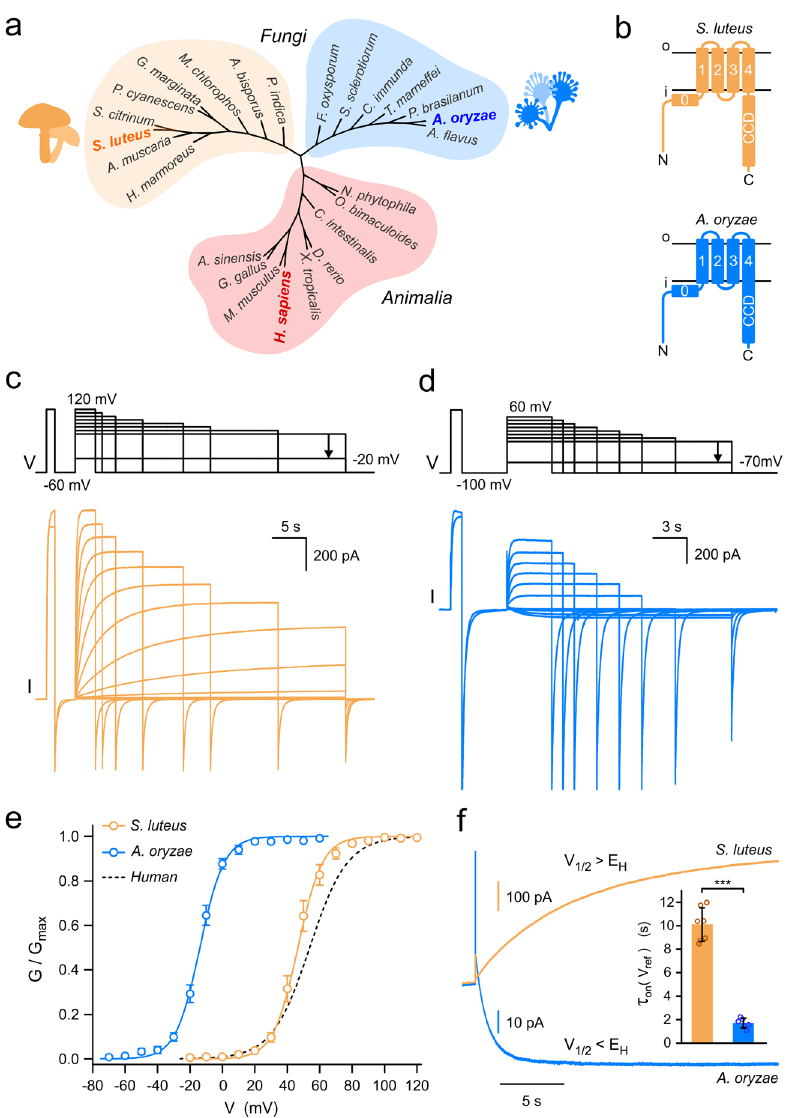
Fig. 1 Fungal Hvs from species S. luteus and A. oryzae show distinct biophysical properties. a Unrooted cladogram places Hv channels of fungi into two large groups distinct from animal orthologs. b Predicted topology of Hvs from S. luteus and A. oryzae showing connections between C-terminal coiled-coil domains (CCD) and S4 transmembrane segment of different lengths. c , d Representative proton currents from fungal Hvs shown in ( b ) expressed in Xenopus oocytes and measured from inside-out patches (pH = pH = 6.0). For clarity, only the fi rst and last traces elicited by the depolarization pre-step i o are shown. e Conductance versus voltage relationships ( G – V s) of SlHv1 and AoHv1 calculated from current traces like those shown in ( c , d ). Curves are Boltzmann fi ts. For SlHv1, V 1/2 = 46.5 ± 2.3 mV, slope = 7.6 ± 0.5 mV; for AoHv1, V 1/2 = − 13.9 ± 1.1 mV, slope = 7.4 ± 0.9 mV ( n = 5). Error bars are SEM. G – V for hHv1 is shown as dashed line for reference ( V = 53 ± 3 mV, slope = 11.6 ± 0.6 mV, from ref. 28 ). f Representative activation currents of SlHv1 and 1/2 AoHv1, each measured at a reference voltage ( V ref ) closest to their individual V 1/2 ( V ref = 50 mV for SlHv1 and − 10 mV for AoHv1). At V ref , G / G max is 0.61 and 0.63 for SlHv1 and AoHv1, respectively. E H indicates Nernst potential for protons, which in this case is 0 mV. Time constants of activation currents ( τ on ( V ref )) are shown in inset as mean values ± SEM ( n = 7 for SlHv1; n = 6 for AoHv1). Welch ’ s t -test was used for statistical analysis, *** p < is observed with the large majority of Hvs from the animal with SlHv1 activating slowly, and at positive membrane poten- kingdom 11 . AoHv1, on the other hand, opens when the tials, and AoHv1 activating rapidly, and at negative membrane potentials (Fig. 1c – e). The conductance vs. voltage relationship electrochemical gradient favor proton in fl ux, with V 1/2 < E H (Fig. 1f, I ( V 1/2 ) < 0). Besides being opposite in sign, the currents ( G – V ) of SlHv1 was slightly left-shifted compared to the G – V of from SlHv1 and AoHv1 measured at a reference voltage V ref ≈ V 1/2 hHv1 (Fig. 1e, V 1/2 = 46.5 ± 2.3 mV for SlHv1, V 1/2 = 53 ± 3 mV reached steady-state level at different rates. To quantify the for hHv1 28 ), whereas the G – V of AoHv1 was strongly left-shifted (Fig. 1e, V 1/2 = − 13.9 ± 1.1 mV). difference, we fi tted the currents with a single-exponential The two fungal channels also differed in their ability to conduct function. From the comparison of the relative time constants τ inward current, which depends on the relationship between the on ( V ref ), we concluded that AoHv1 is approximately sixfold faster than SlHv1 (Fig. 1f, bar graph). As previously observed with voltage range of activation and the Nernst potential for protons animal Hvs 11 , the time course of activation of SlHv1 and ( E H ). SlHv1 opens under electrochemical gradients that favor proton ef fl ux, with V 1/2 > E H (Fig. 1f, I ( V 1/2 ) > 0), similar to what AoHv1 showed a time lag between the beginning of the